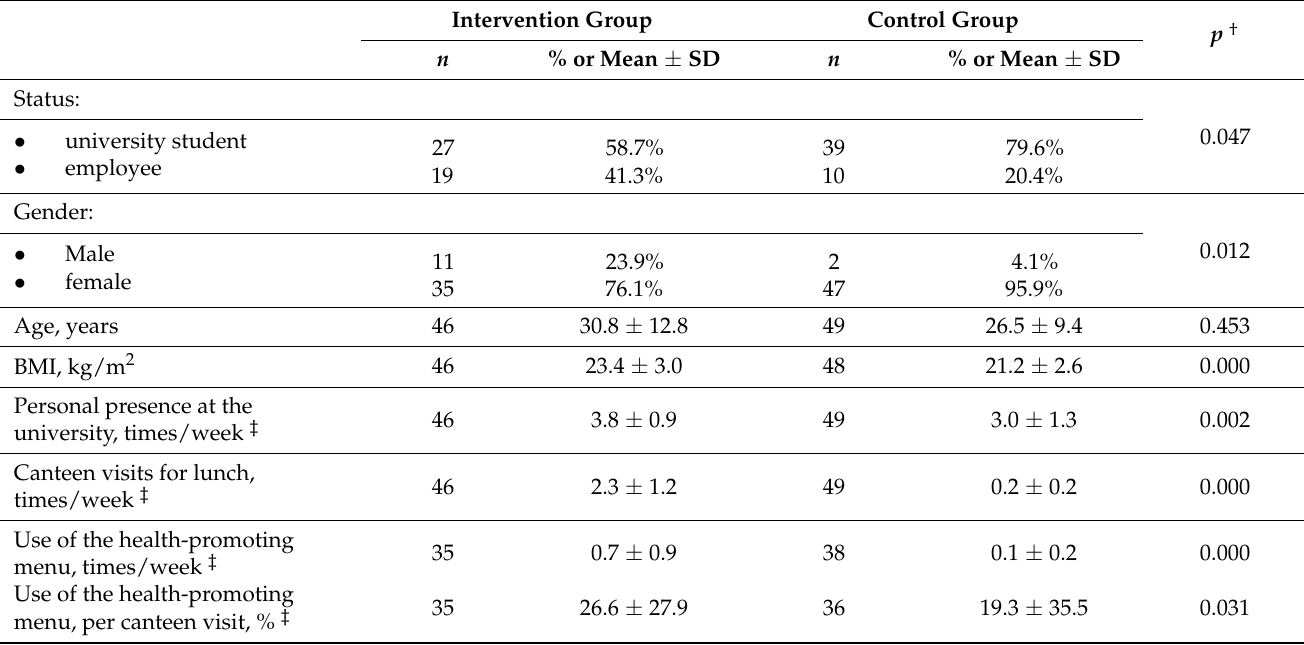
Table 2. Characteristics of study participants according to